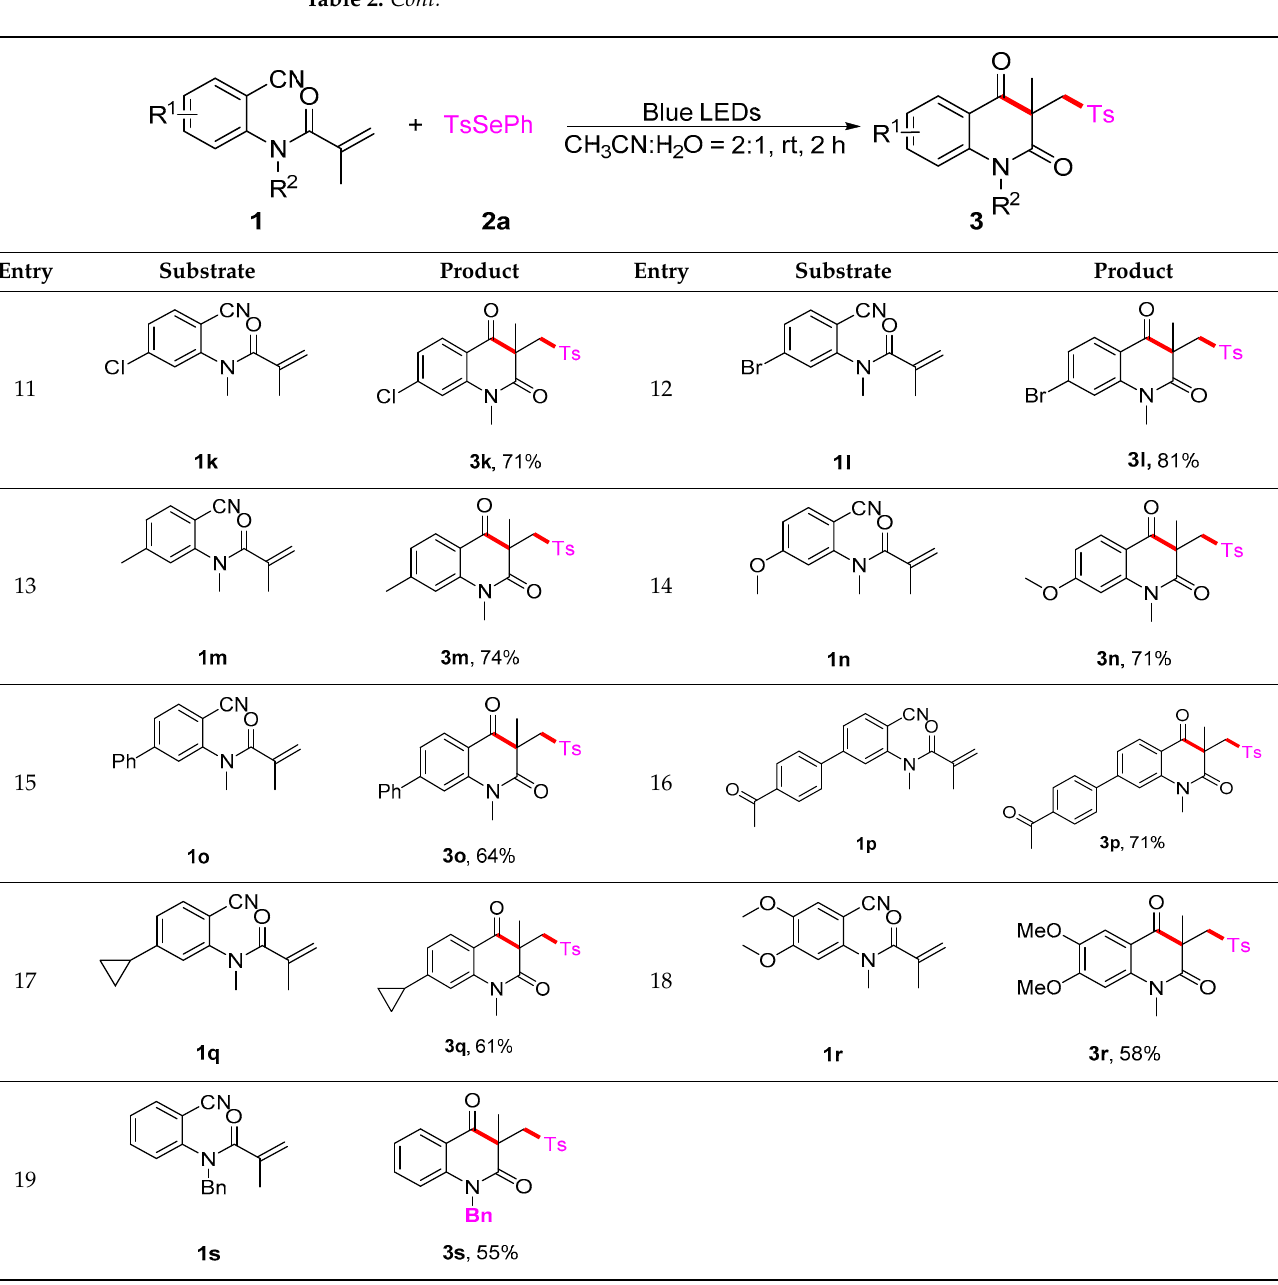
In view of the previous report on the visible light-induced tandem reaction of allene and selensulfonate24, the process is mainly due to photoinduced radical addition through energy transfer. Therefore, we tried to introduce different derivatives of TsSePh into our reaction system as the radical sources. As shown in Table 3, the corresponding target mol- ecules 3t – 3y were obtained in good yields (51%–81%), indicating a wide functional group tolerance. Specifically, for the p -toluenesulfonyl part of 2 , when methyl was replaced by - H, -OMe or halogen atom (-F, -Cl, -Br), the reaction proceeded smoothly in good yields (74%–81%). Notably, derivatives of 2 bearing cyclopropyl or naphthalene were also com- patible with this cascade reaction, affording the desired products 3w and 3x with 71% and 75% yields,